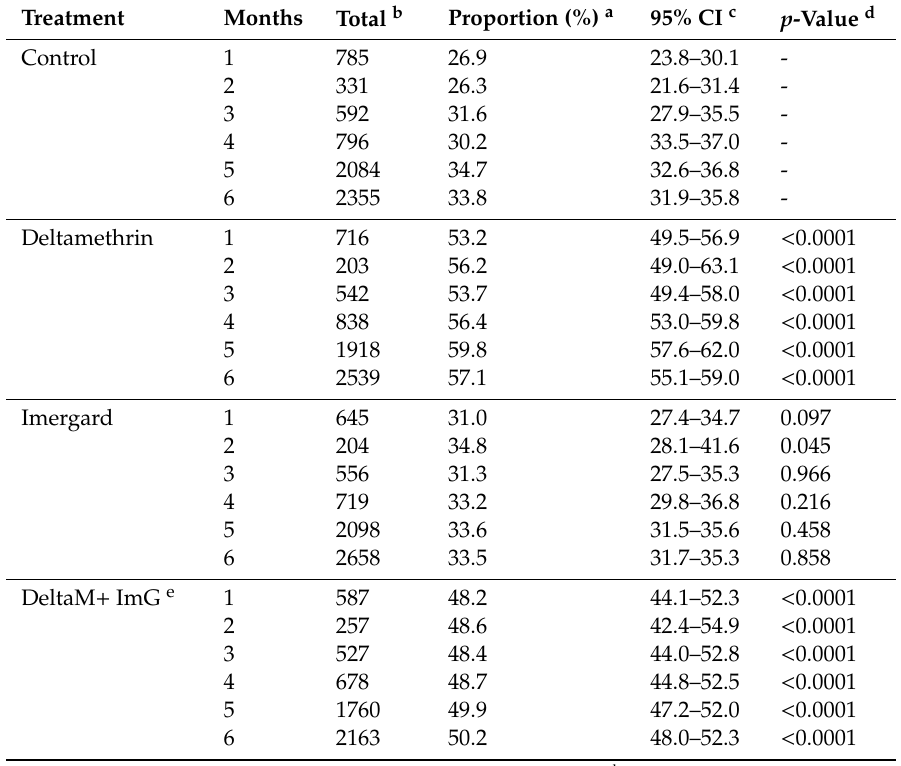
Table 2. Exophily rates a at di ff erent times after spraying for wild-type An. gambiae